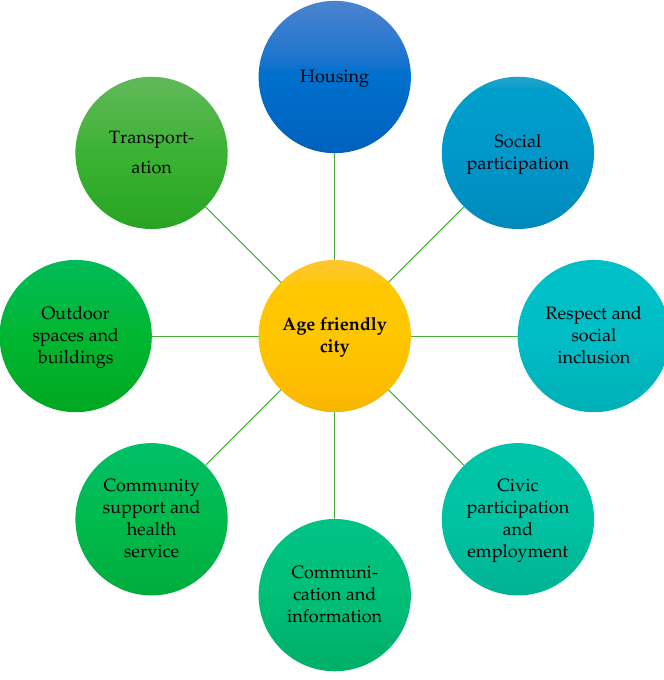
Figure 1. The key areas in WHO’s age-friendly city guidelines [8] (WHO 2007a).